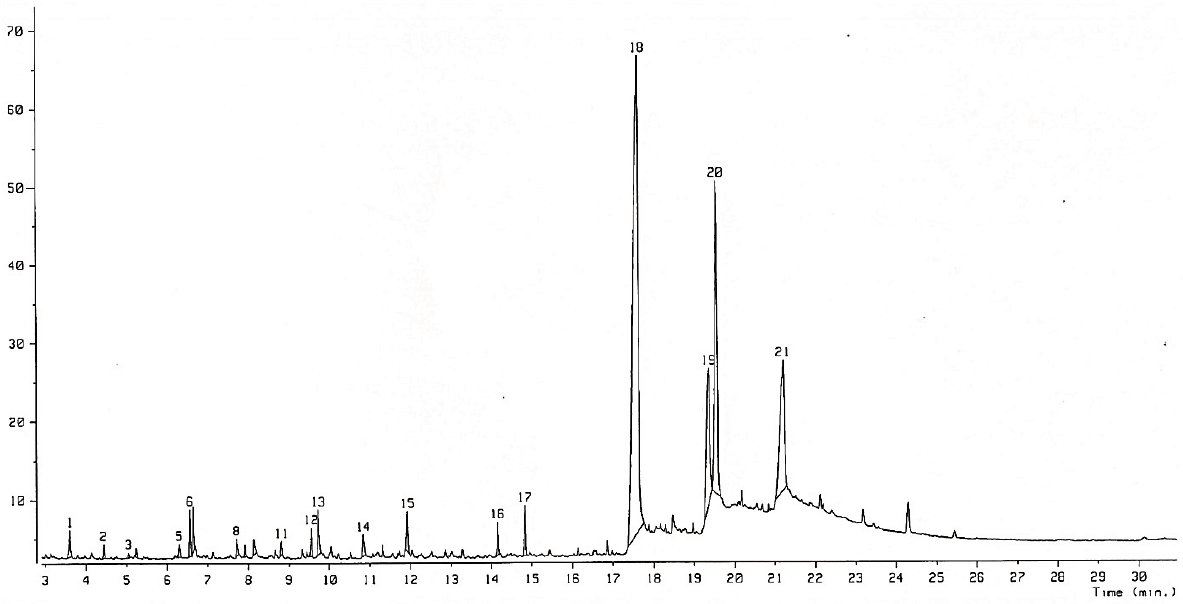
Figure 1. Dried sheet of Laminaria japonica L. and extracted essential oil.